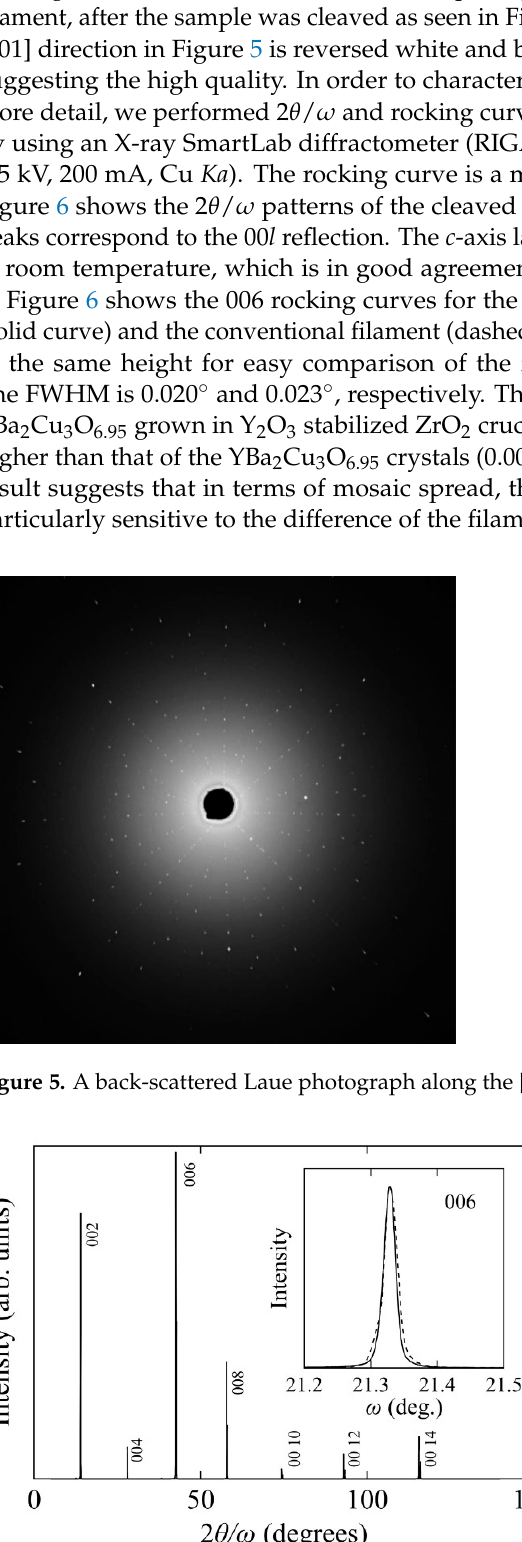
Figure 7. Specific heat divided by temperature ( C P /T ) as a function of temperature below 2 K. A clear transition at 1.5 K is seen. Additionally, the residual density of states is small when C P /T ex- trapolates to zero Kelvin. 4. Concluding Remarks We have demonstrated the improvement of the crystal growth of Sr 2 RuO 4 using an improved filament with single-layered structure. The new filament has the same maxi- mum power (2 kW) as the conventional double-layered filament. The molten zone is nar- rower, enabling better stability during growth. We succeeded in obtaining larger crystals fully 12 cm long, the maximum size available for our furnace. X-ray and heat capacity characterization demonstrate that the grown crystal has high quality. We also note that the growth of another ruthenate, Ca 3 Ru 2 O 7 , was successful using the new filament. We therefore emphasize the suitability of the new filament for the crystal growth of materials with low viscosity melts and low surface tension. Another option to narrow the molten zone is to use laser emission, which has seen dramatic developments in recent years [44], and has been reported to have high potential for good molten-zone stability and control [45]. Laser emission can make the zone even narrower than that obtained by the radiation from halogen lamps. However, a “disad- vantage” of laser emission can be that the zone is too sharply defined, leading to cracking of the as-grown crystal because of too sharp a temperature gradient between the molten zone and the grown crystal. Therefore, reduction of the temperature gradient has been developed by improving the laser profile [45]. We note that this kind of cracking was not seen in our cleaved crystals, as shown in Figure 4c.